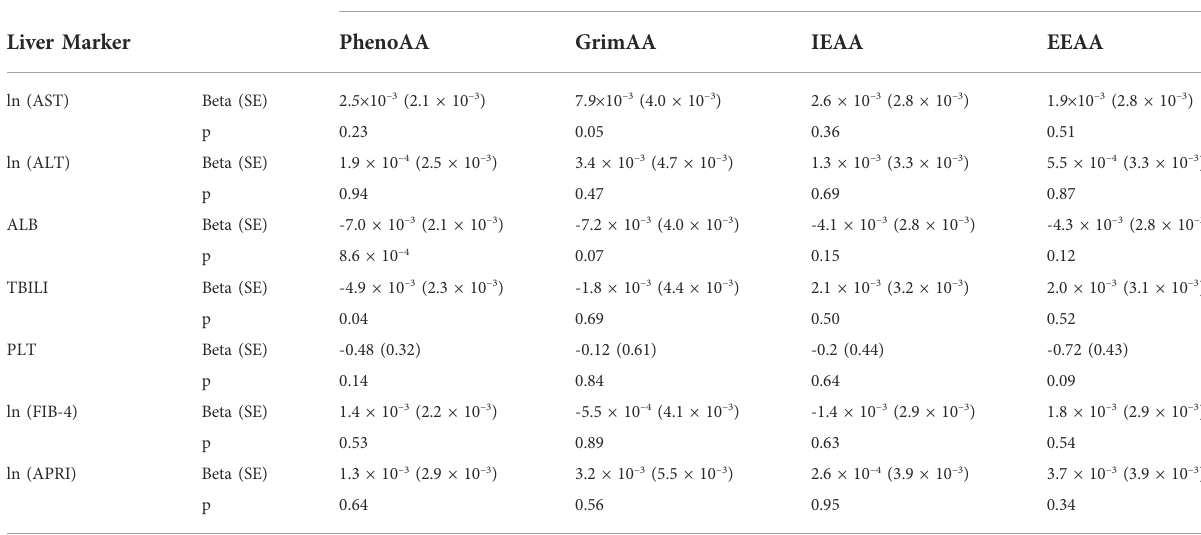
TABLE 2 Associations between DNA methylation age acceleration and selected biomarkers of liver function.